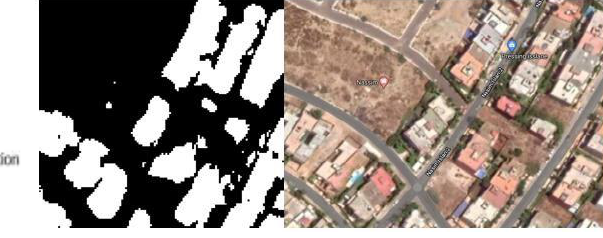
Fig.10 : Test image 1 of Casablanca city (unseen areas)